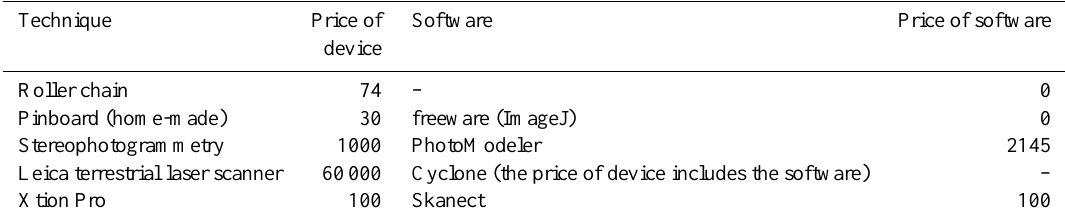
Table 2. Approximate prices related to roughness measurement devices. All prices are in euros. Note that the prices might be subject to change depending on country, might be lower due to temporary offers, and might fluctuate subsequent to the time in which this study was done.